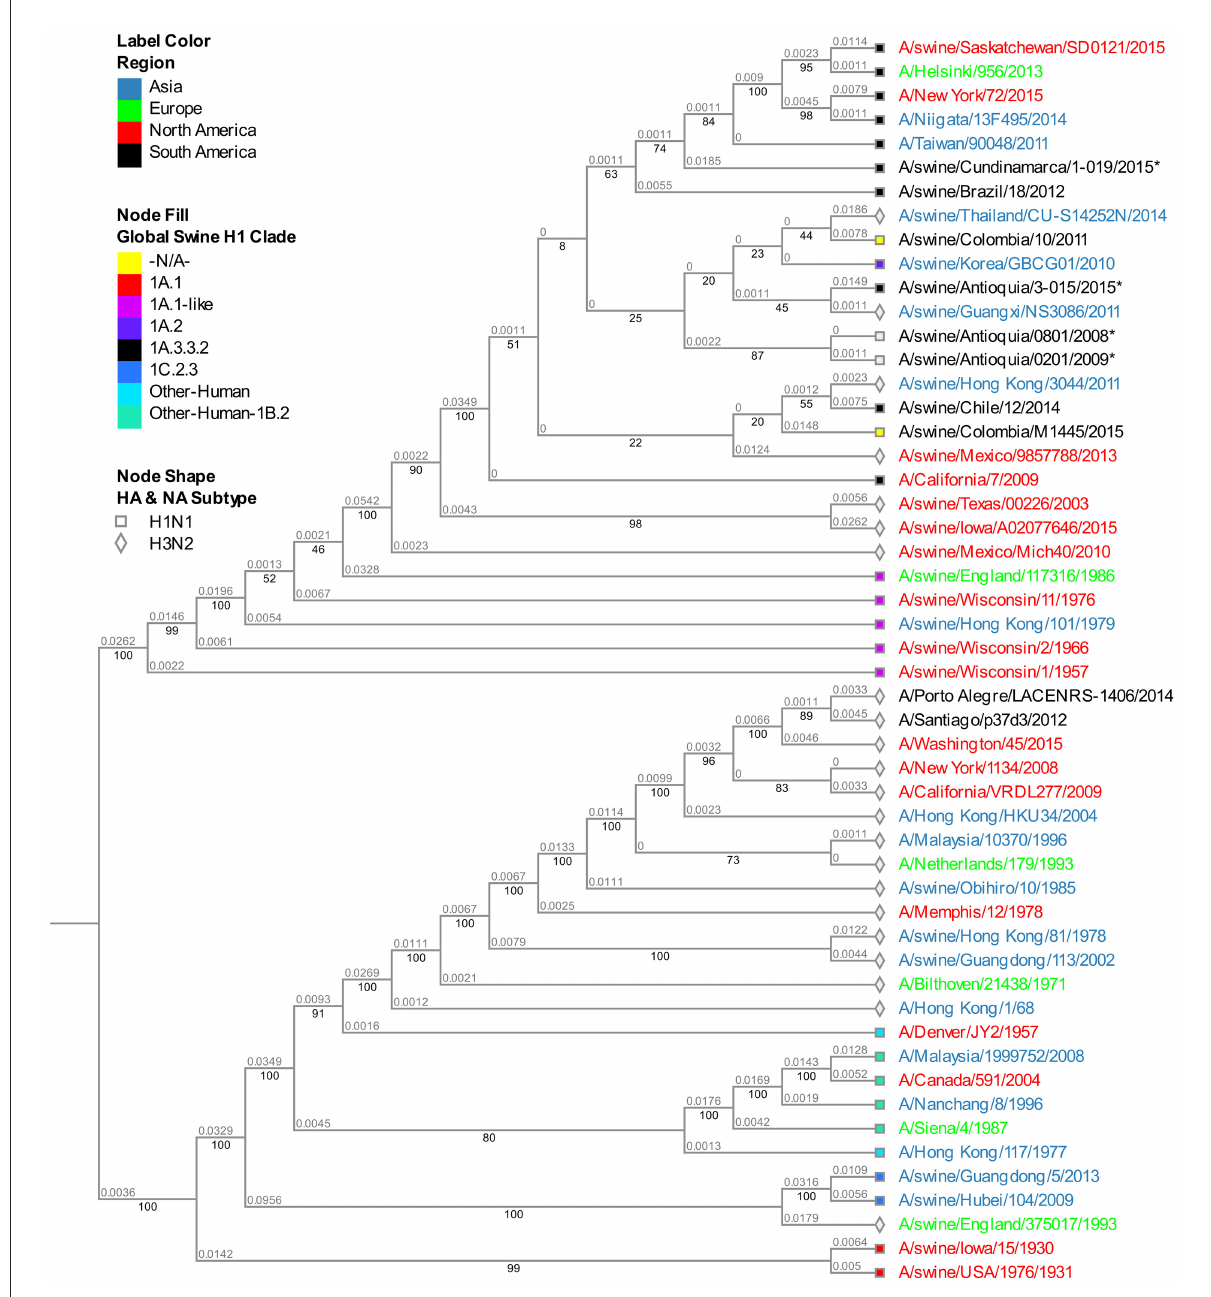
FIGURE4 Phylogenetic analysis for NS gene of swine influenza A virus. Phylogenetic tree was generated using RAxML program for maximum likelihood-based inference. The reliability of the trees was inferred by bootstrap analysis with 1,000 replications. The tree was constructed with representative sequences from human and swine H1N1 classical and H1N1pdm09, as well as human and swine H3N2. Colombian isolates included on this study are labeled with asterisks.